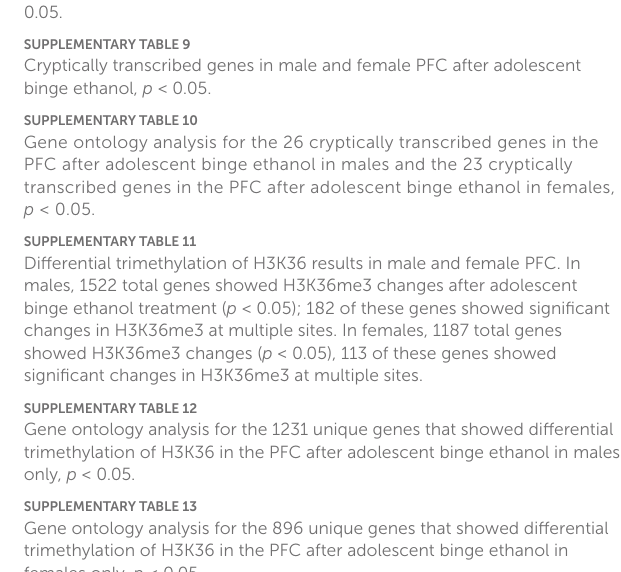
SUPPLEMENTARY TABLE 4 Gene ontology analysis for the 45 genes differentially expressed in the PFC after adolescent binge ethanol in both males and females, p < 0.05. SUPPLEMENTARY TABLE 5 Differential exon use results in male and female PFC. SUPPLEMENTARY TABLE 6 Gene ontology analysis for the 461 genes showing differential exon usage in the PFC after adolescent binge ethanol in males only, p < 0.05.